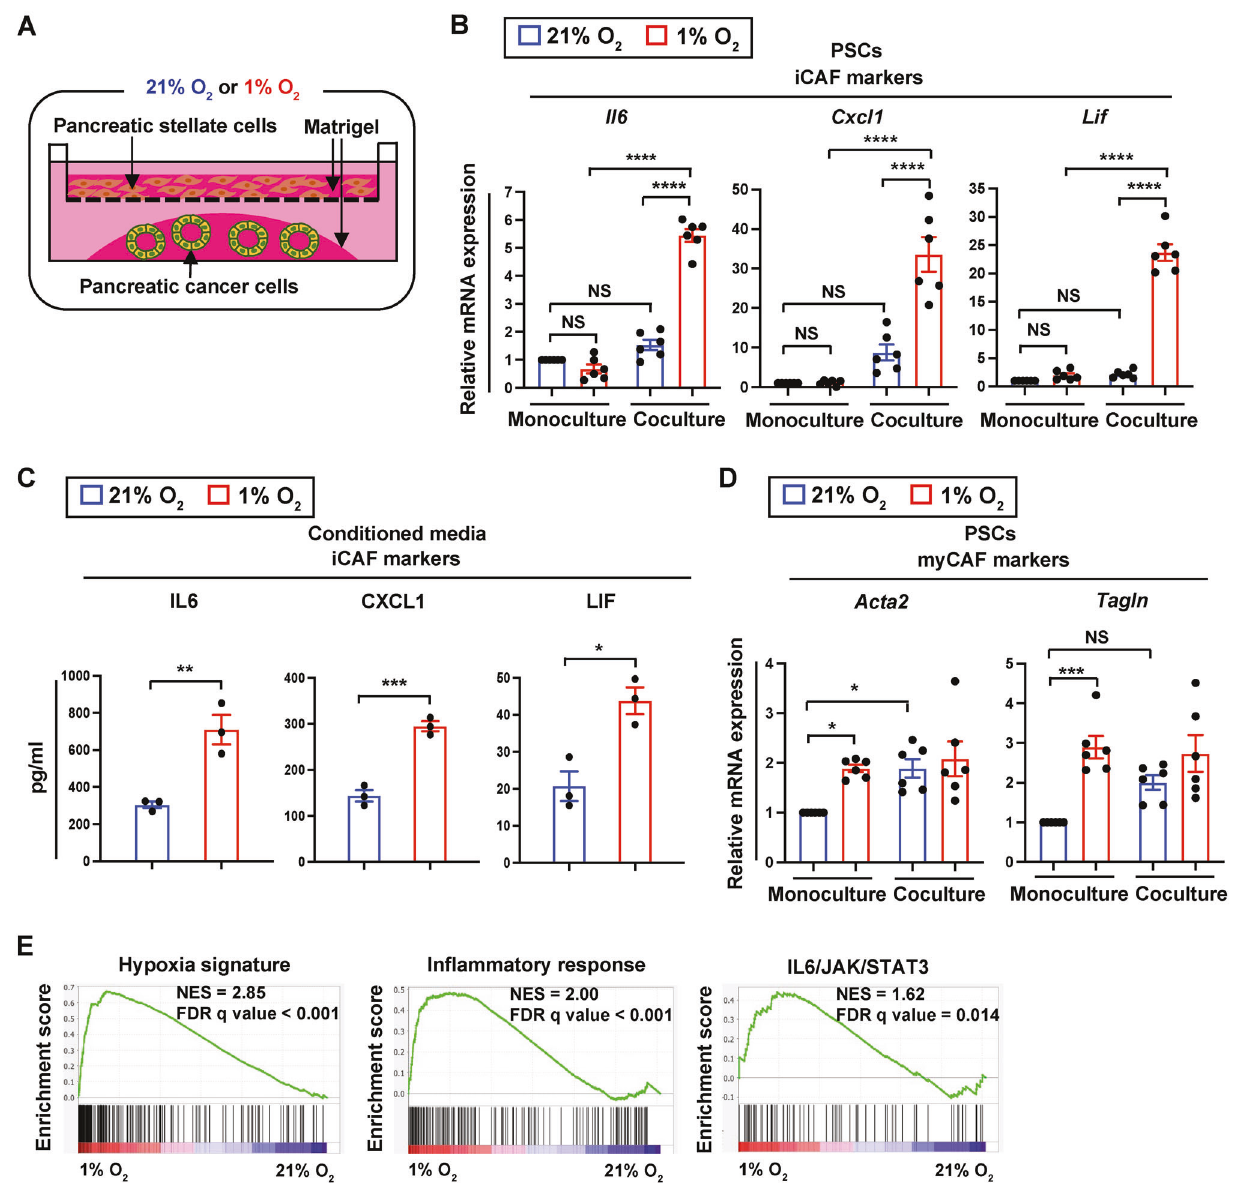
Fig. 2 Hypoxia promotes an in fl ammatory fi broblast phenotype. A Schematic illustration of the 3D coculture platform to model tumor cell- PSC interactions under normoxia and hypoxia. B Quantitative RT-PCR analysis of iCAF markers in PSCs cultured alone or with mT3 tumor organoids under 21% O 2 or 1% O 2 for 48 h ( n = 6). Expression levels were normalized by 18S rRNA . C Enzyme-linked immunosorbent assay (ELISA) of iCAF markers in conditioned media from 3D cocultures of PSCs and mT3 tumor cells under 21% O 2 or 1% O 2 for 72 h ( n = 3). D Quantitative RT-PCR analysis of myCAF markers in PSCs cultured alone or with mT3 tumor organoids under 21% O 2 or 1% O 2 for 48 h ( n = 6). Expression levels were normalized by 18S rRNA . E Gene set enrichment analysis (GSEA) showing signi fi cantly upregulated pathways in PSCs cultured with mT3 tumor organoids at 1% O 2 compared with PSCs cultured with mT3 tumor organoids at 21% O 2 for 48 h. NES normalized enrichment score, FDR false discovery rate. Each data point in B – D represents individual primary PSC lines. Data in B – D , mean ± SEM. P- values were determined by two-way ANOVA with Bonferroni post-test ( B , D ) and student ’ s t -test ( C ). NS not signi fi cant. * p < 0.05; ** p < 0.01; *** p < 0.001; **** p <